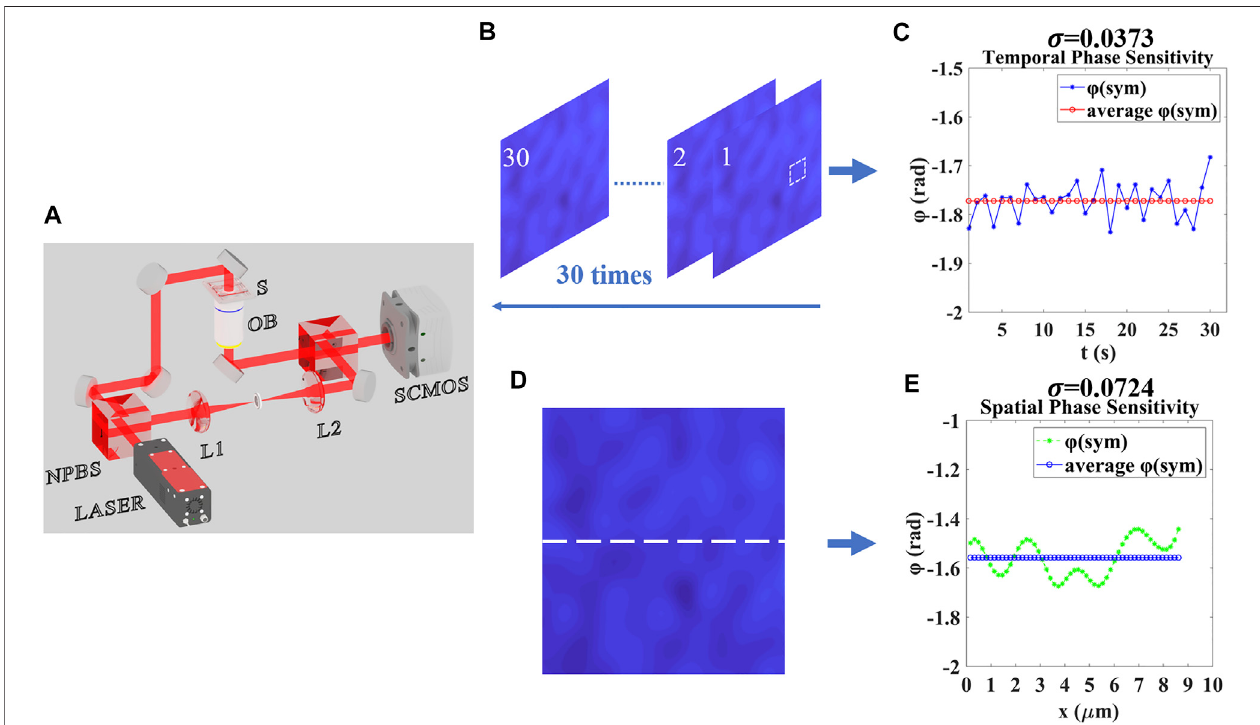
FIGURE1| Workingprincipleandspatiotemporalcalibrationofthesystem. (A) Schematicoftheexperimentalsetup.NPBS,non-polarizedbeamsplitter;SCMOS, scienti fi c complementary metal-oxide-semiconductor camera; OB, objective lens; S, stage. (B) 30 s phase measurement of the system without sample. (C) Temporal Phase Sensitivity. (D) phase measurement of the system without sample along the white line. (E) Spatial Phase Sensitivity. φ (sym): phase of the system without sample, σ : Standard deviation of the phase without sample.